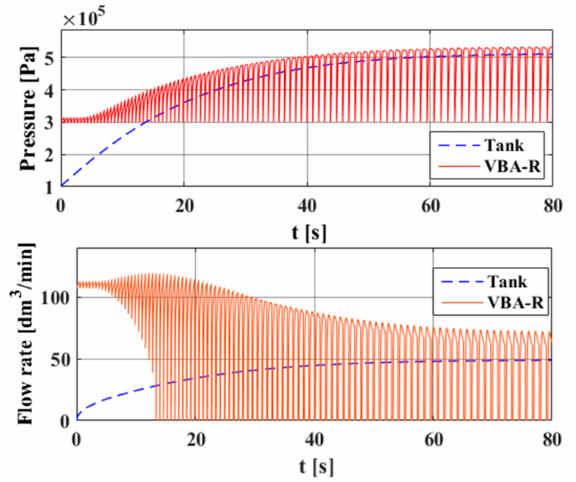
Figure 11. Pressure/flow rate response of VBA-R and tank.